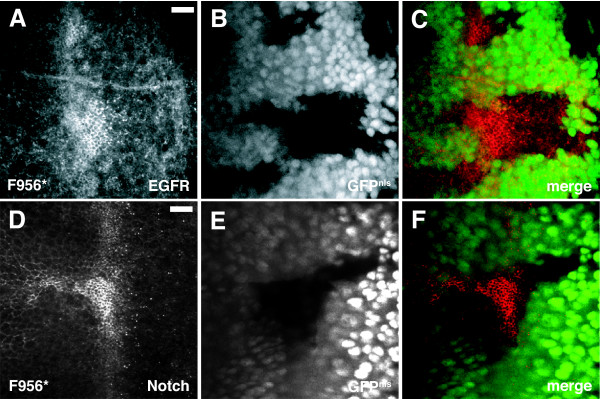
dAux mutants show elevated levels of EGF and Notch receptor expression. Spinning disk confocal images of Act5C>FLP/+; FRT5-5Z3515, dAuxF956*/FRT5-5Z3515, ubi-GFPnls eye disc stained for (A-C) Drosophila EGF receptor (red in merged panel) and (D-F) Notch receptor (red in merged panel). dAuxF956* mutant cells are indicated by the absence of nuclear GFP. Scale bar, 10 μm.